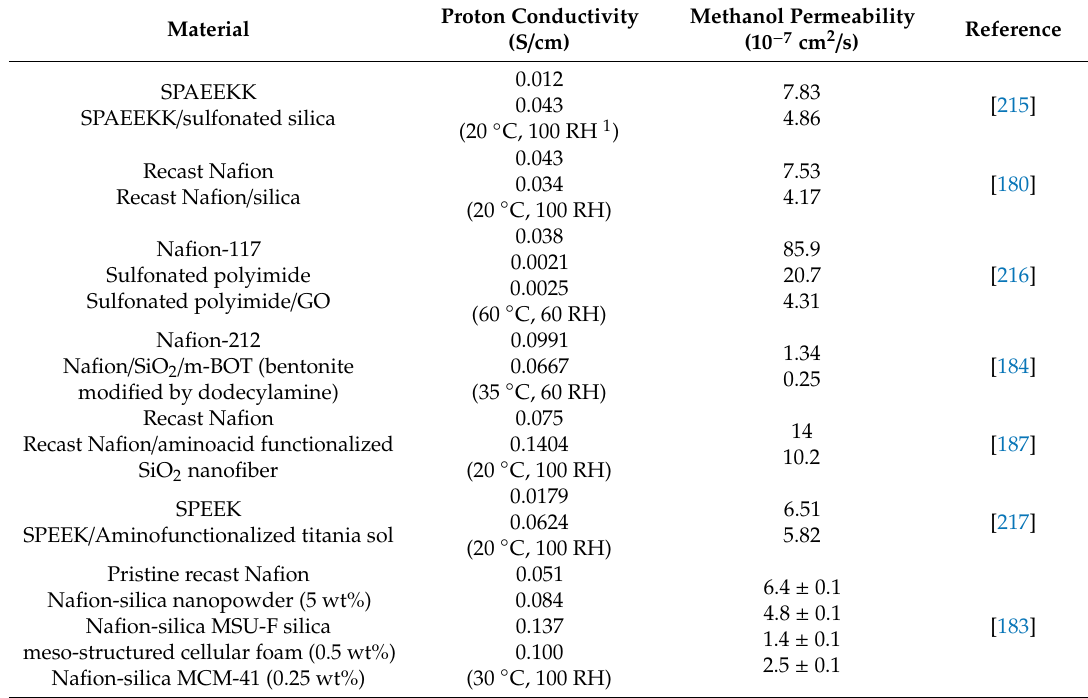
Table 1. Comparison of the proton conductivity and methanol permeability of various PEMs for DMFCs